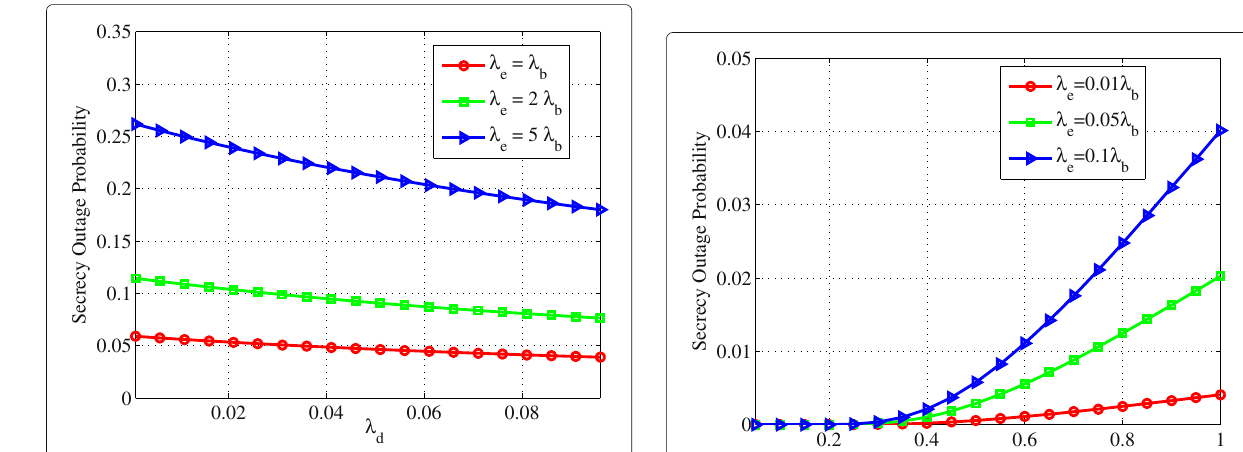
Fig. 5 The secrecy outage probability of the typical cellular link in scenario I versus the density of the D2D user λ d under different densities of the eavesdropper λ e where λ b = 0.0001 / m 2 . Figure 5 illustrates the relationship between the secrecy outage probability of the typical cellular link in scenario I and the density of the D2D user